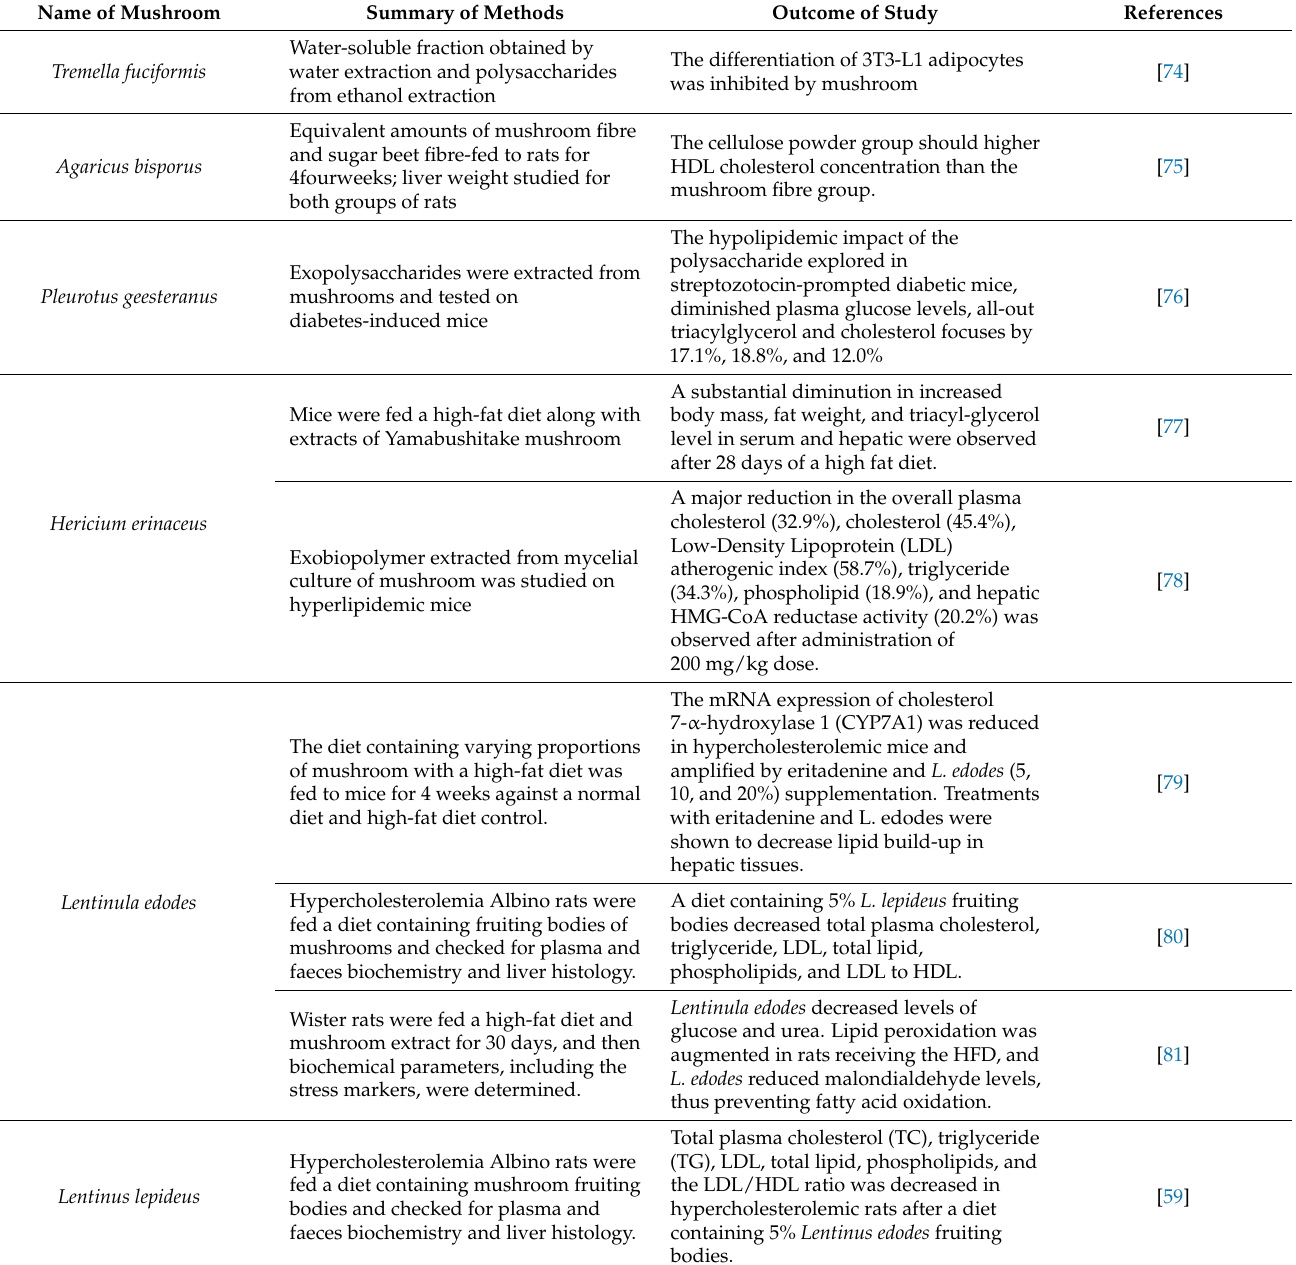
Table 1. Weight loss, anti-obesity, and hypolipidemic properties of